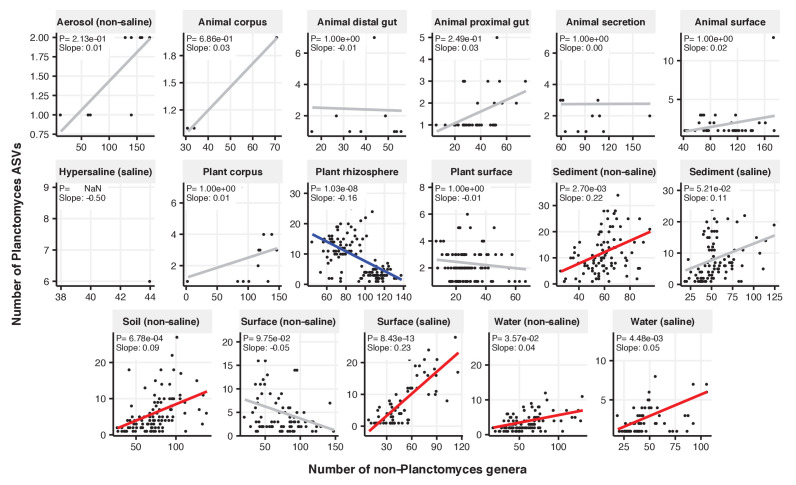
Focal-lineage diversity as a function of community diversity across biomes in Planctomyces.Linear models are shown for ASVs per genus (y-axis) as a function of community diversity (non-focal genera, x-axis) in each of the 17 environments (EMPO3 biomes). Only environments containing the focal lineage are shown. Significant positive diversity slopes are shown in red, negative in blue (linear models, p<0.05, Bonferroni corrected for 17 tests), and non-significant in grey.